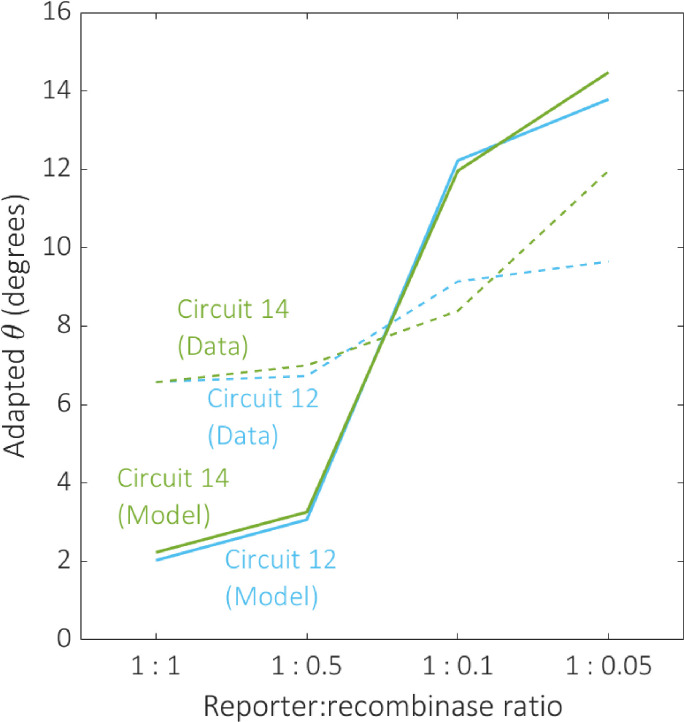
The effect of decreasing recombinase expression on circuit performance.The effect of reducing the reporter:recombinase ratio on performance was examined for the same two circuits selected for data-fitting, circuits 12 (blue) and 14 (green). Dotted and solid plot lines correspond to experimental data and predictive model simulations respectively. The model predictions align qualitatively with our data, demonstrating a decline in circuit performance as recombinase expression decreases.